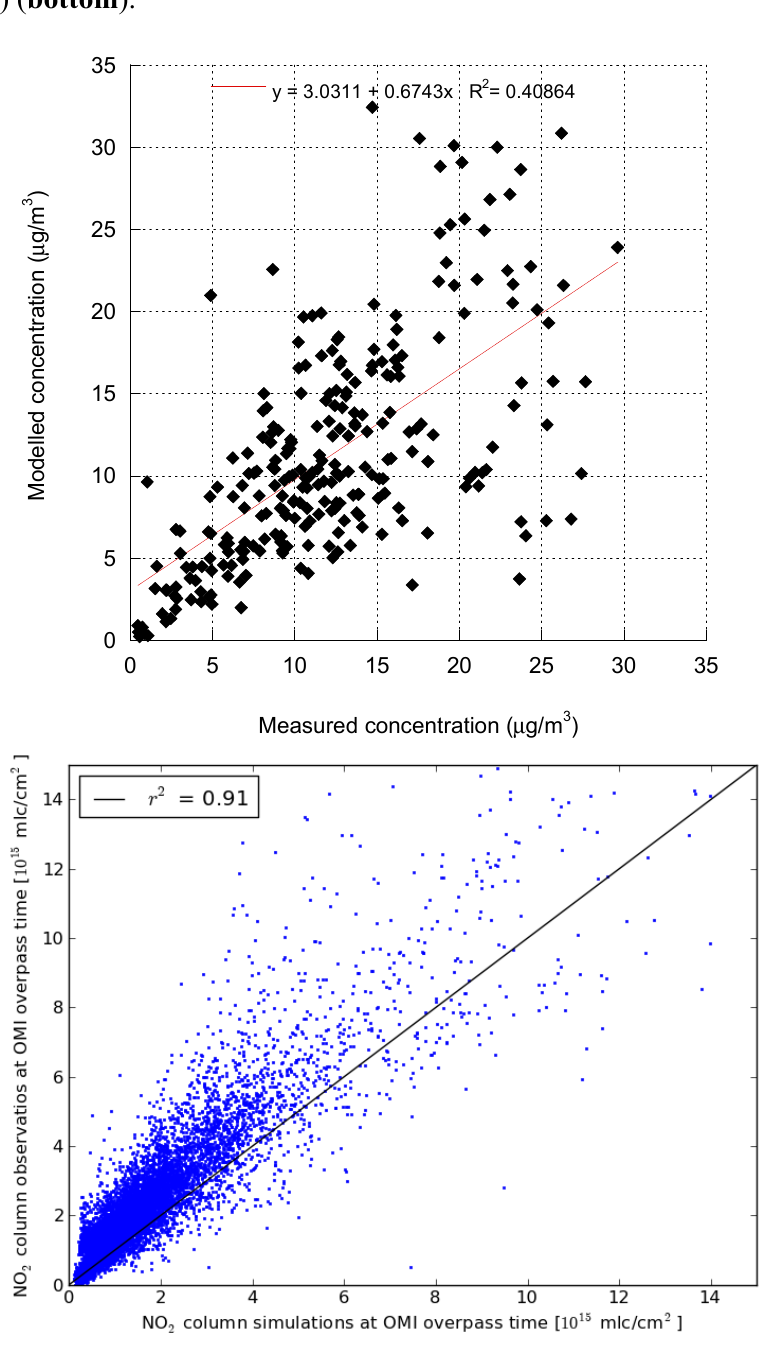
concentrations 2 columns 2